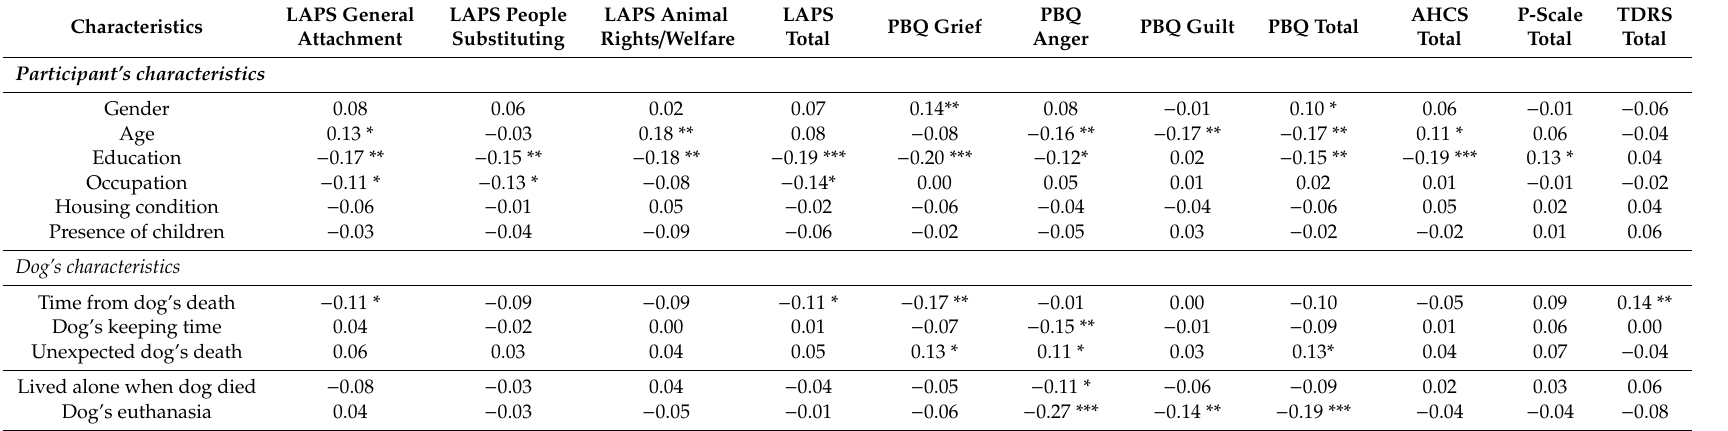
Table 3. Correlations between constructs and participant / dog